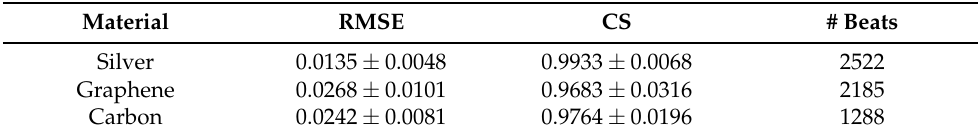
Figure 5. Artifacts present during a regular acquisition. Table 3. RMSE and CS for all beats